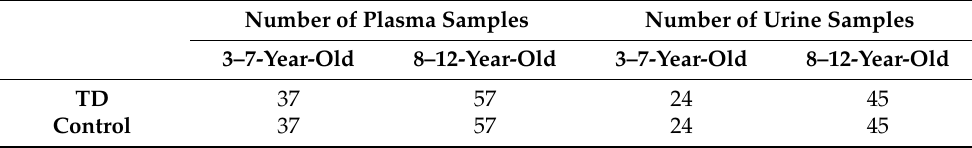
Table 1. The number of plasma and urine samples in patients in the TD and control